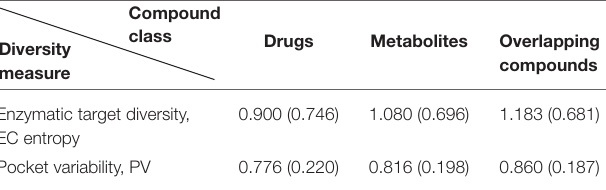
TABLE 3 | Compound-type specific target protein